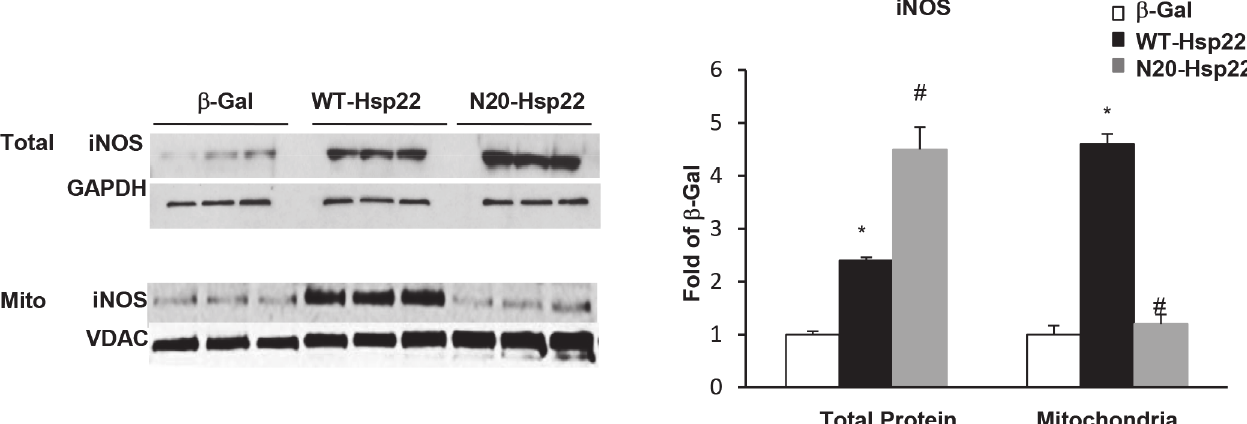
Fig 7. Mitochondrial translocation of iNOS by Hsp22. iNOS expression in total cell lysates and mitochondrial fractions from myocytes treated with Ad-WT- Hsp22 or Ad-N20-Hsp22 compared to β -Gal. * , P < 0.05 vs β -Gal; #, P < 0.05 vs Ad-WT-Hsp22. n = 6 per